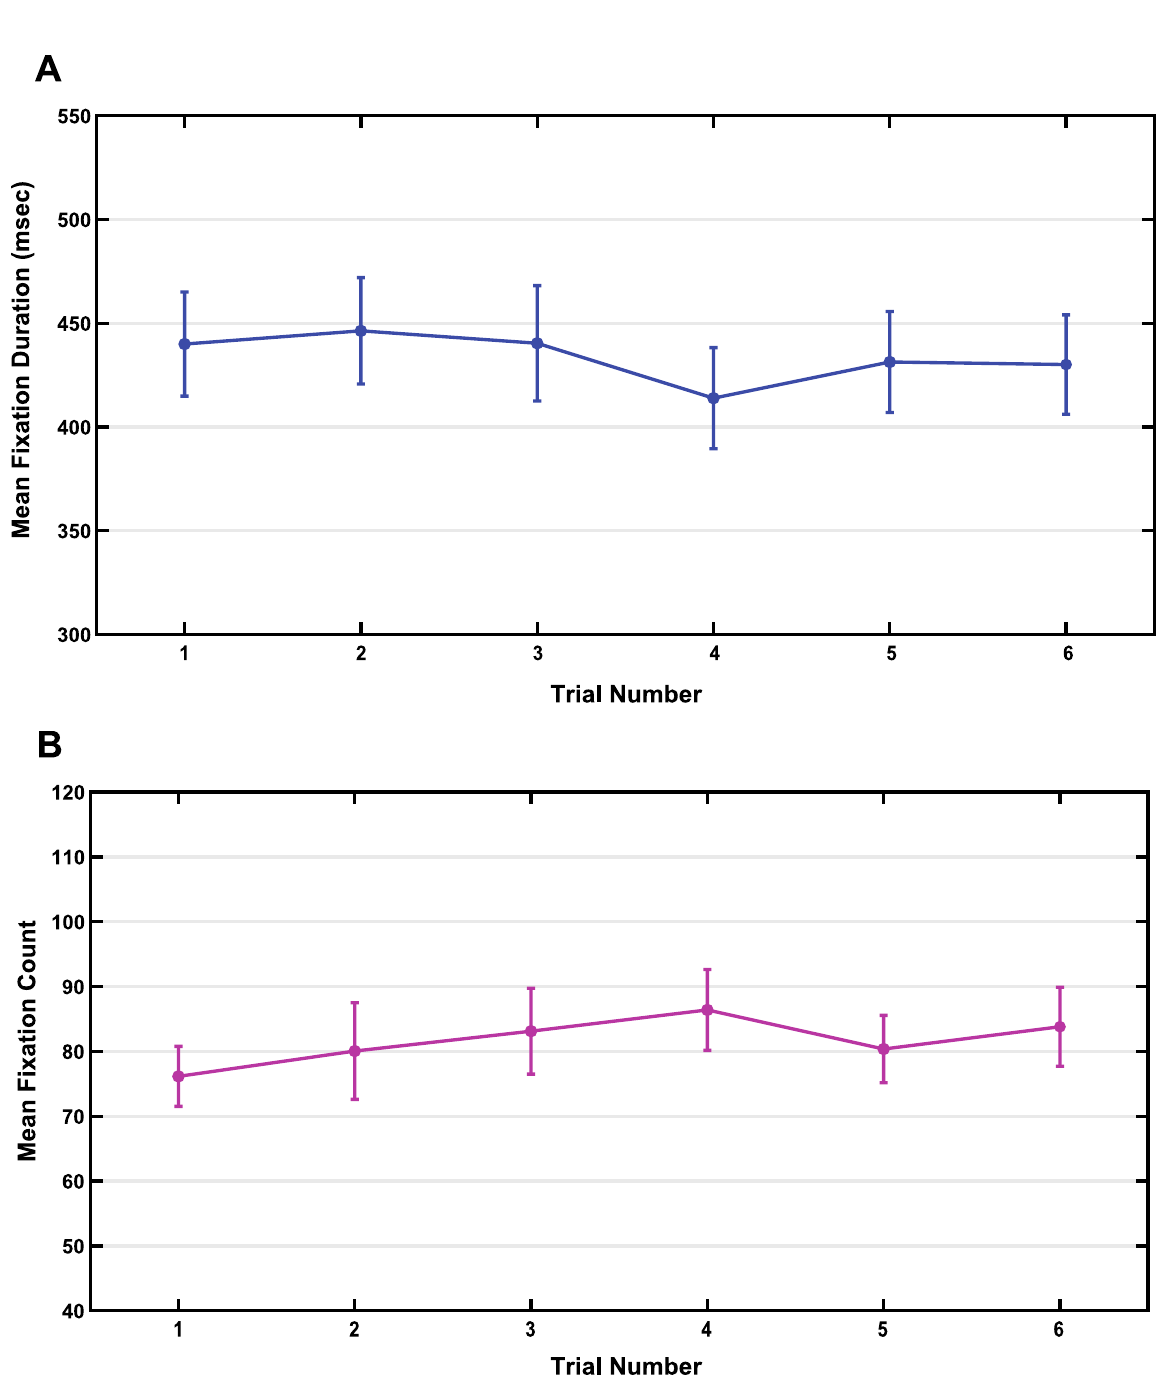
Fig 11. Fixation metrics across time for thresholded data. There were no significant differences in fixation duration (A) or count (B) across the 6 trials of data collected. Data presented as mean +/- 1